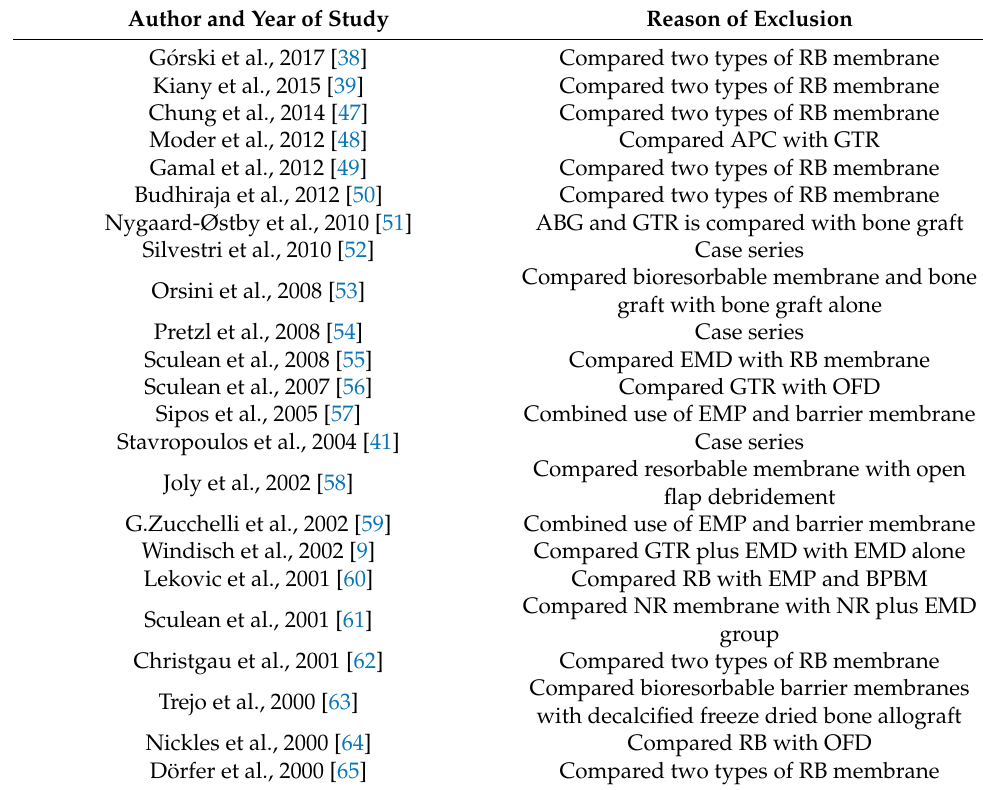
Table A1. List of excluded studies after reading the full